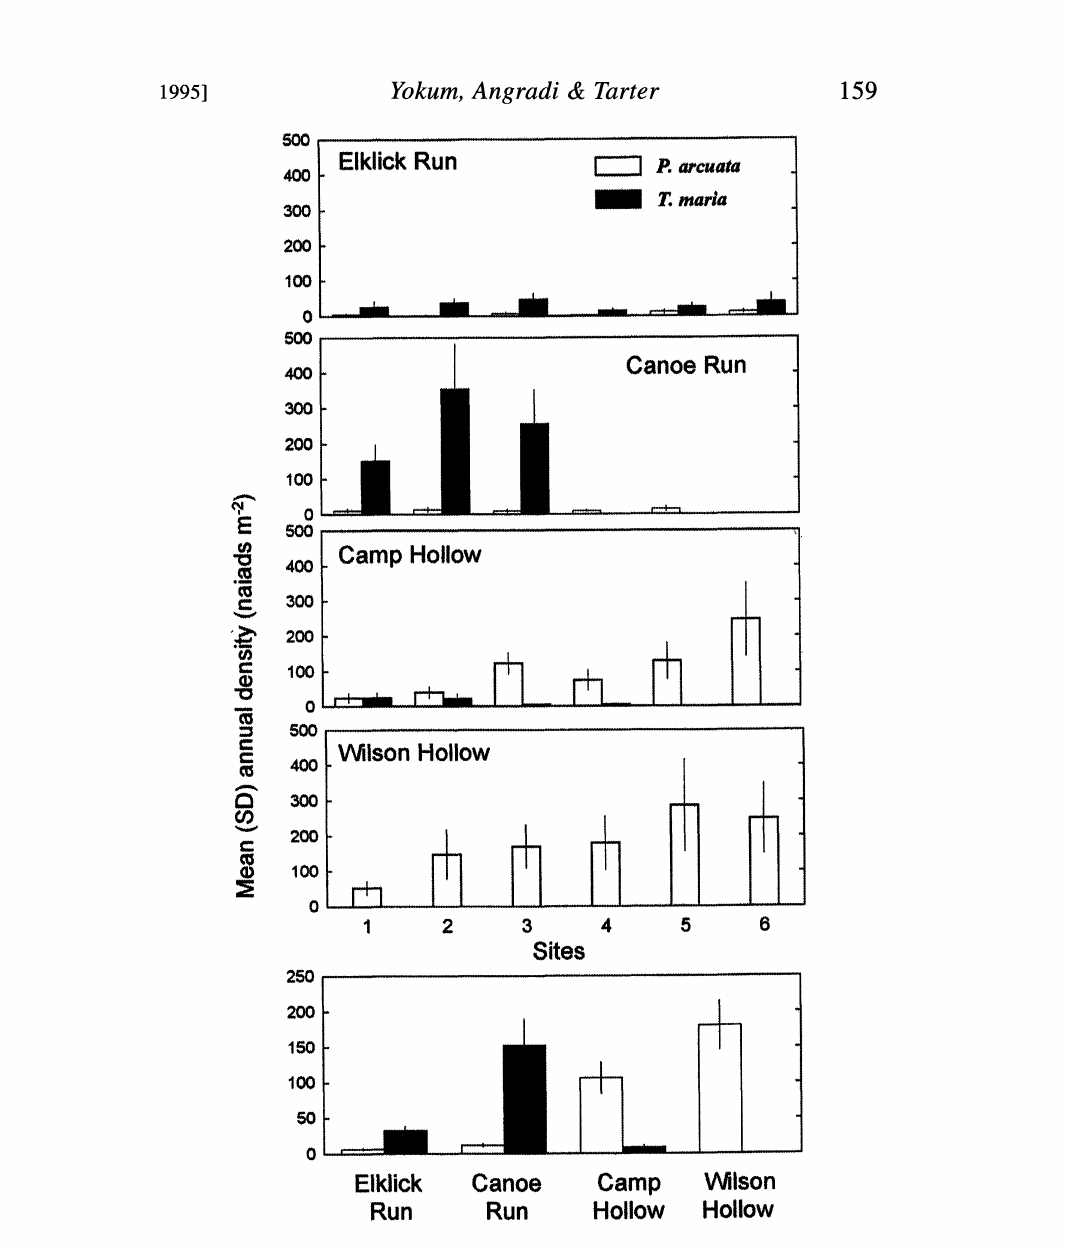
Fig. 3. Mean density of peltoperlid naiads at Fernow study sites and for sites at each stream combined. Sites are as in Fig. and Table 1. There was no site 6 at Canoe